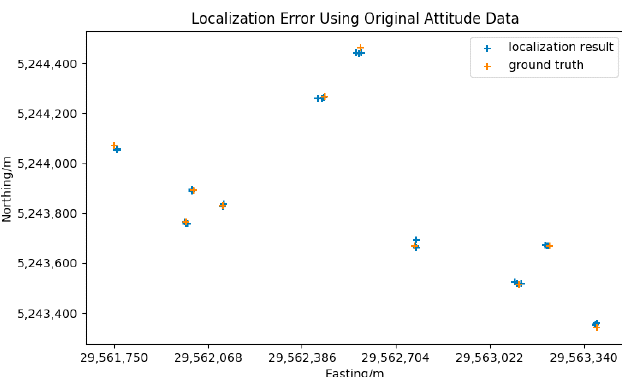
Figure 13. Comparison of localization results and actual geodetic coordinates.